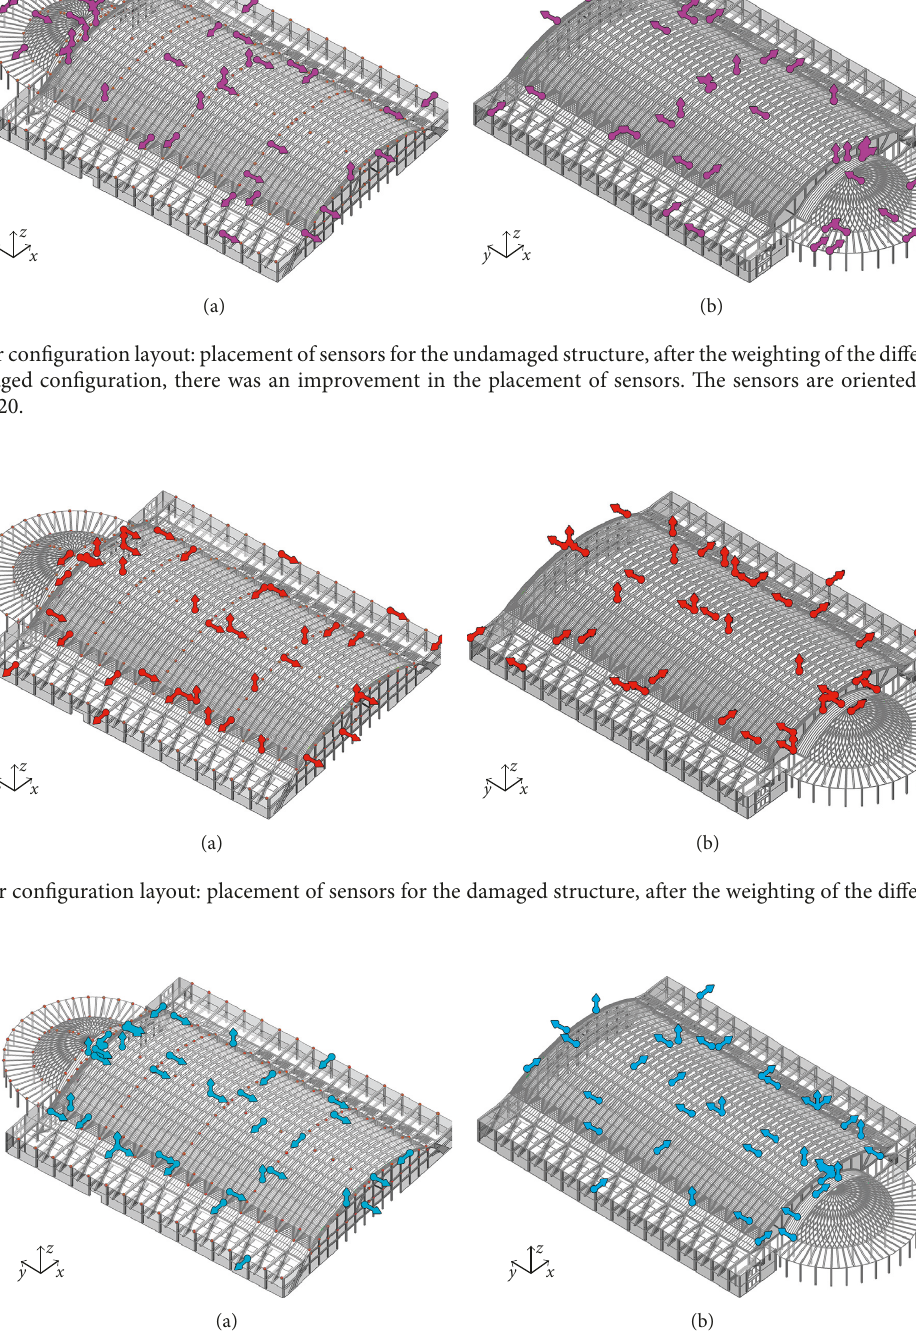
Figure 21: The mixed configuration setup applied to Hall